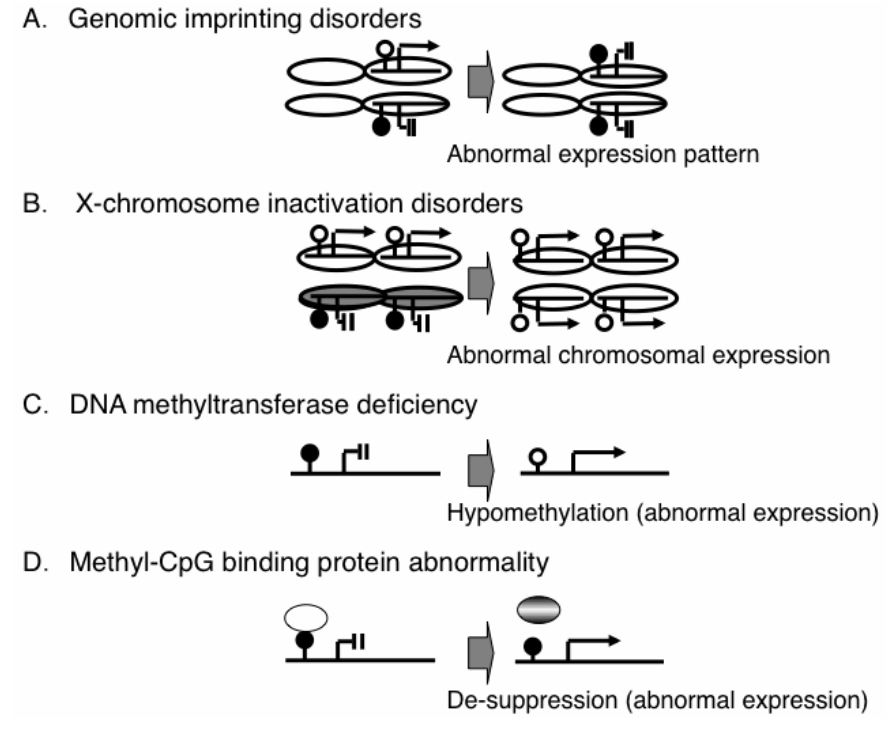
Figure 2. Abnormal epigenetic patterns in human congenital